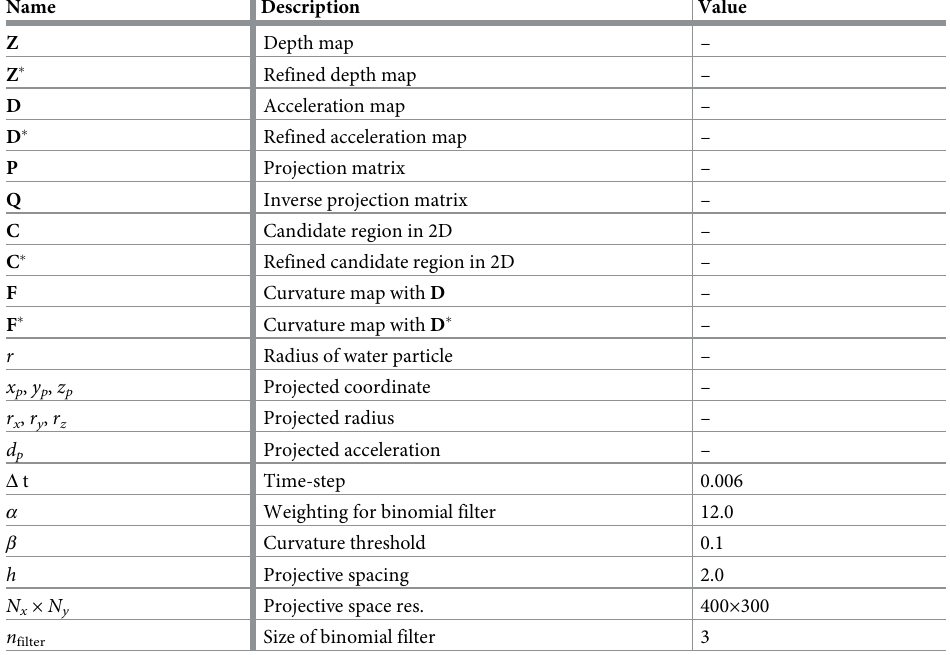
Table 1. Simulation